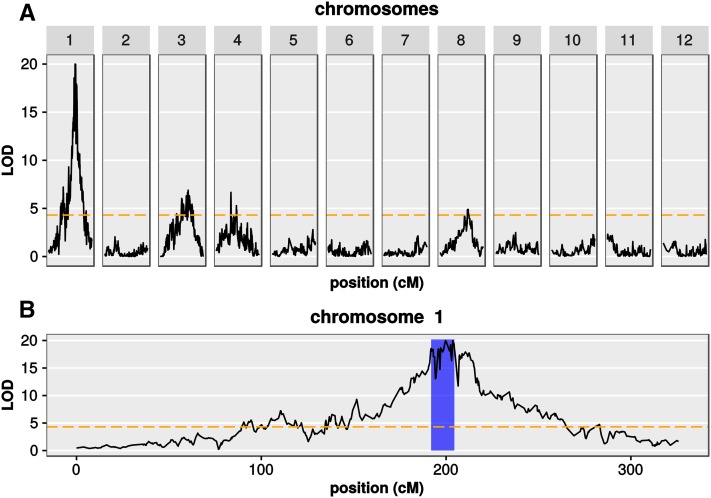
Detection of QTL for tiller number using GBS markers. Shown are the results of a linkage analysis to detect QTL that have an effect on tiller number using data from joined spring and fall datasets with up to 75% missing data per marker. LOD scores are shown as black lines for all 12 chromosomes (A), or for chromosome 1 only (B). A LOD threshold for significance (P ≤ 0.05) is shown as a dashed orange line. The blue area in (B) highlights the 95% confidence interval of qOLTN1 (QTL1 for tiller number O. longistaminata). Distances are shown in cM.